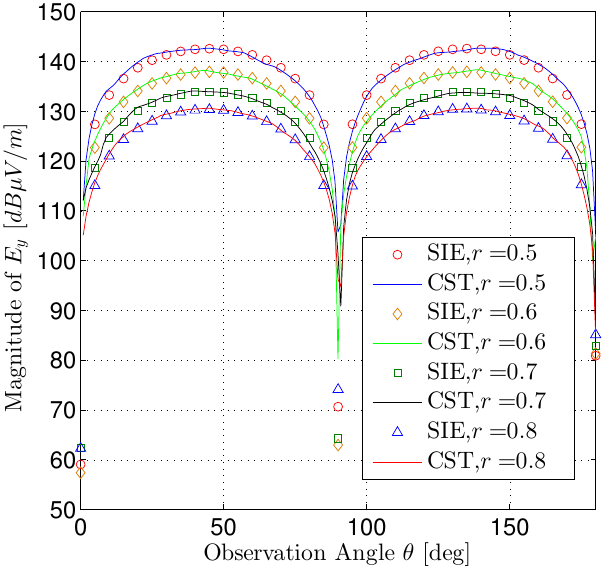
Figure 11. The electric fields E y for observation radius r = 0.5, 0.6, 0.7 and 0.8